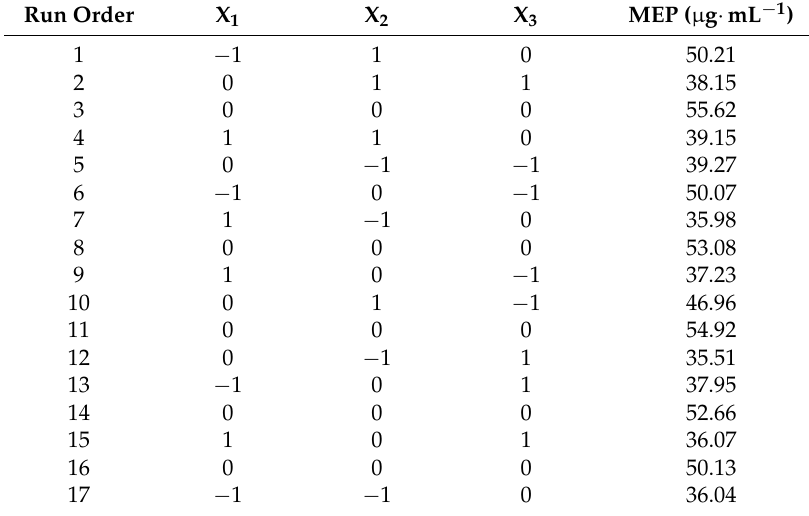
Table 1. Experimental design of code levels and factors in respond surface methodology (RSM) by Box–Behnken design (BBD) matrix. MEP: Morchella esculenta